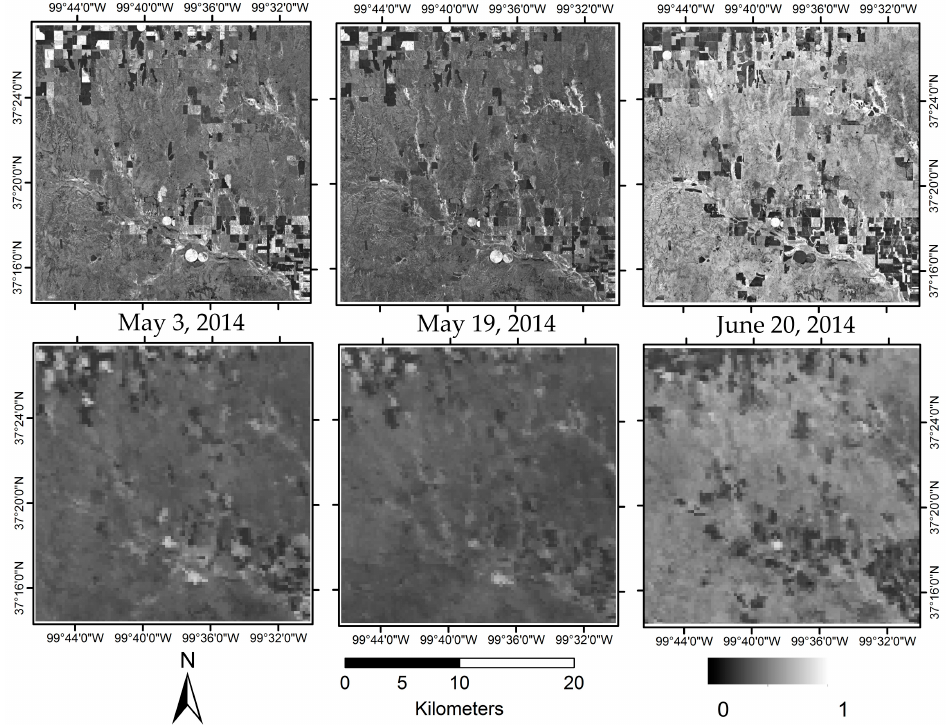
Figure 4. Landsat ( upper row )l and MODIS ( lower row ) NDVI images from three dates in 2014 over a mixed crop and grassland area in Kansas, U.S.